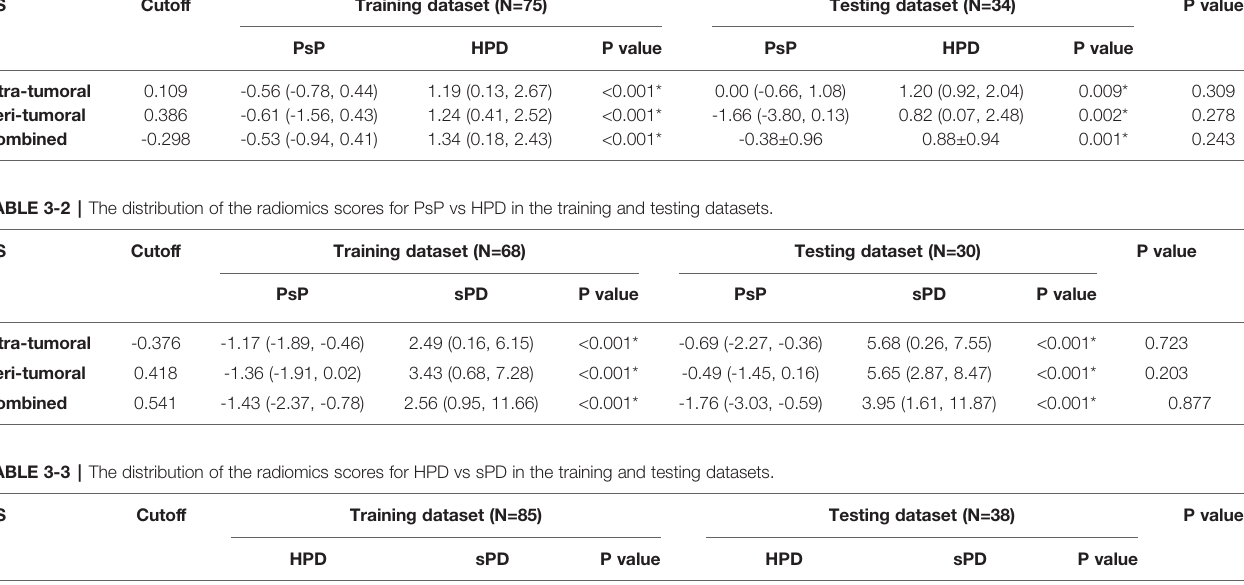
TABLE 3-1 | The distribution of the radiomics scores for PsP vs HPD in the training and testing datasets. RS Cutoff